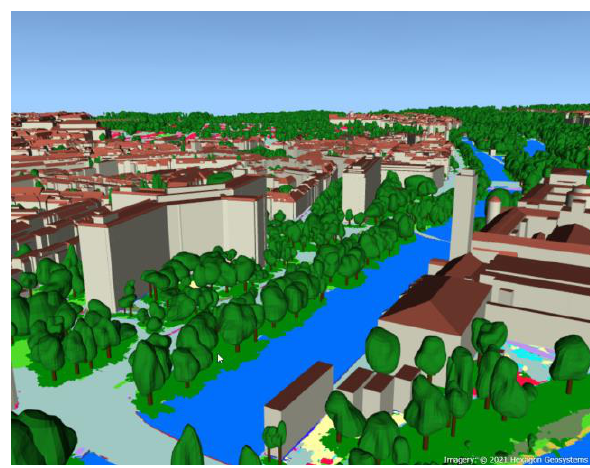
Figure 11: Automatic result of 3D land use and LOD2, produced by Melown Technologies, using CityMapper-2 data with 5 cm GSD